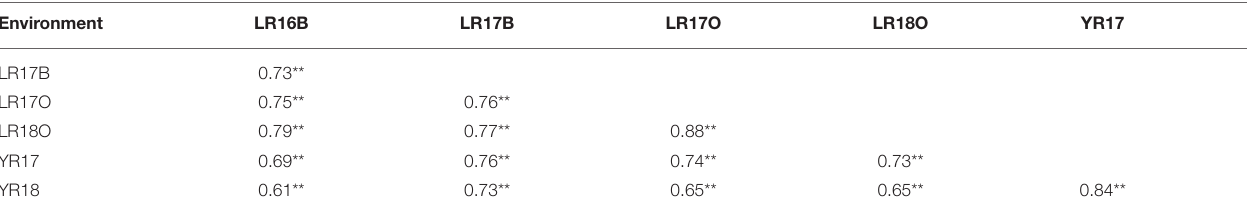
TABLE 3 | Pearson correlation coefficients (r) for two-way comparisons of leaf rust and stripe rust severity data from different environments.